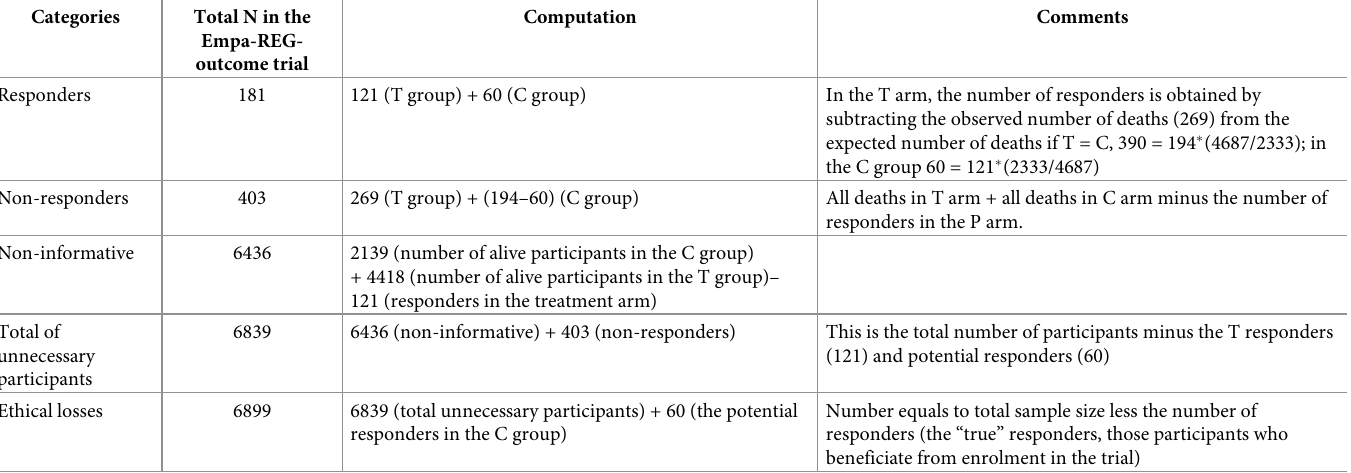
Table 3. Demographic characteristics of